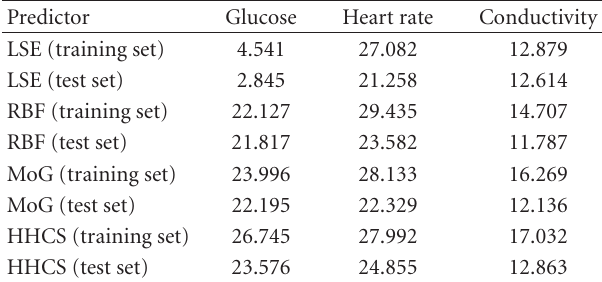
Table 5: Prediction of biological time series (dB).